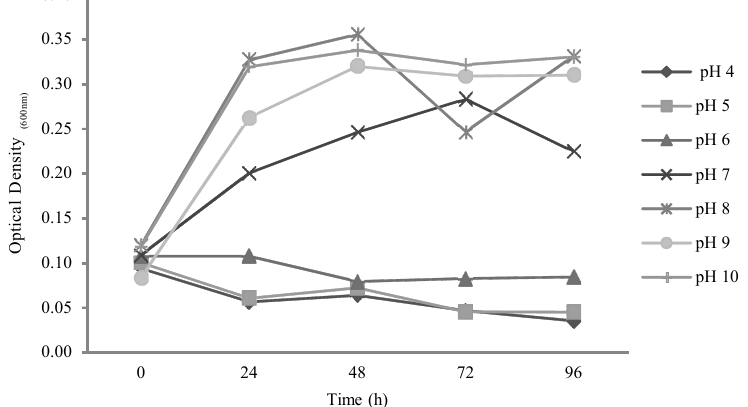
Fig. 2: Optical density of Rhodococcus pyridinivorans during the experiment under different pH